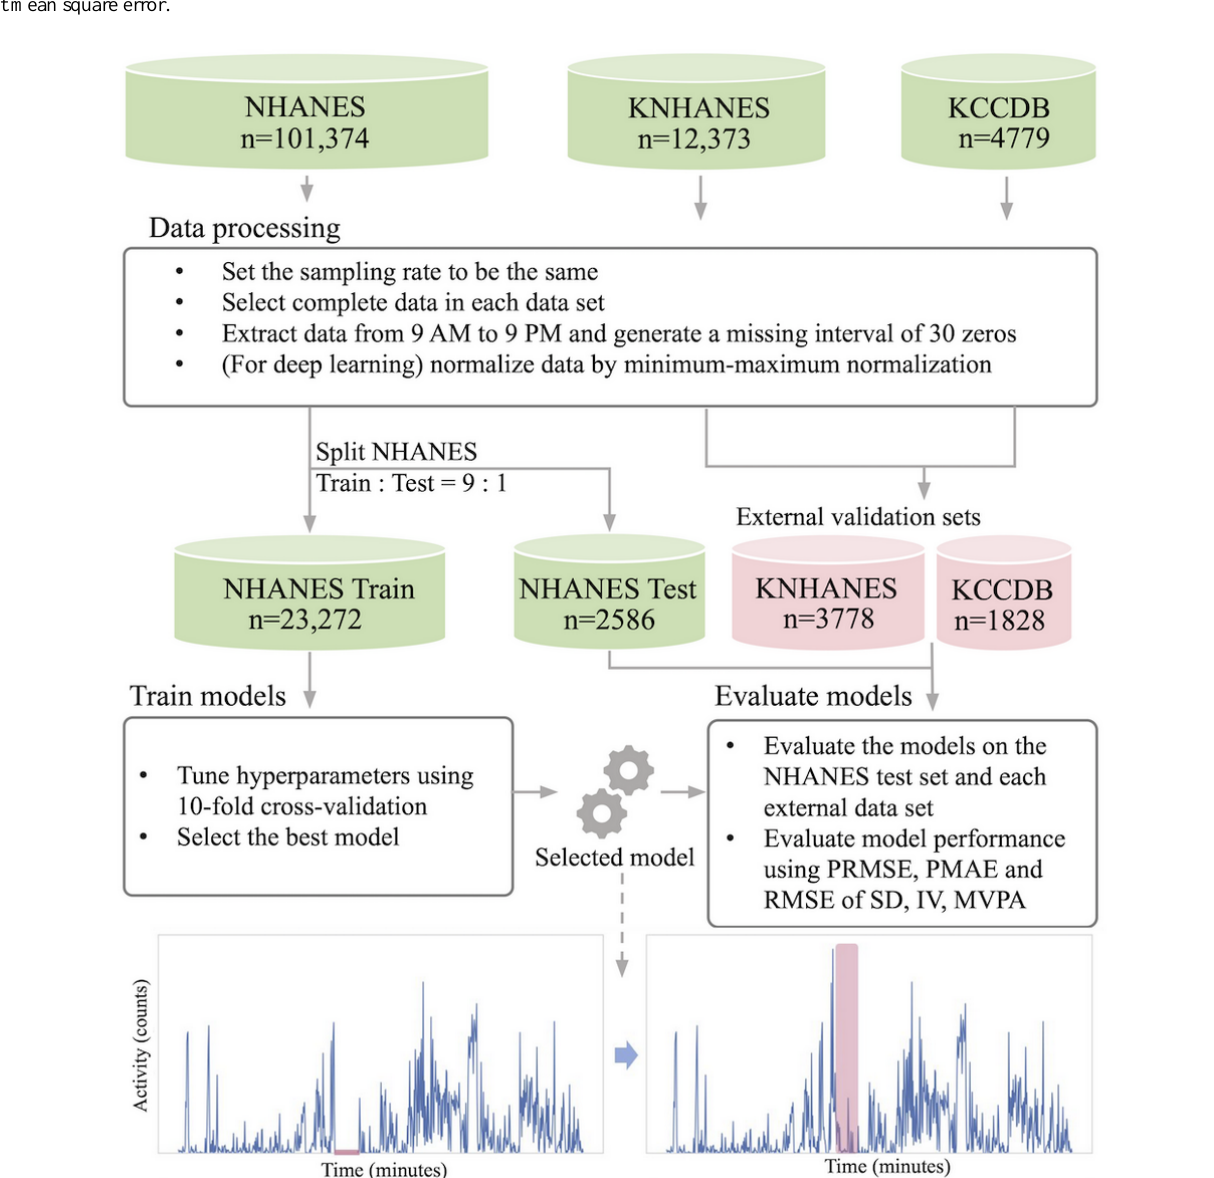
Figure 1. Overview of the study and data where n indicates number of records (days). IV: intradaily variability; KCCDB: Korean Chronic Cerebrovascular Disease Oriented Biobank; KNHANES: Korea National Health and Nutrition Examination Survey; MVPA: moderate-to-vigorous physical activity; NHANES: National Health and Nutrition Examination Survey; PRMSE: partial root mean square error; PMAE: partial mean absolute error; RMSE: root mean square